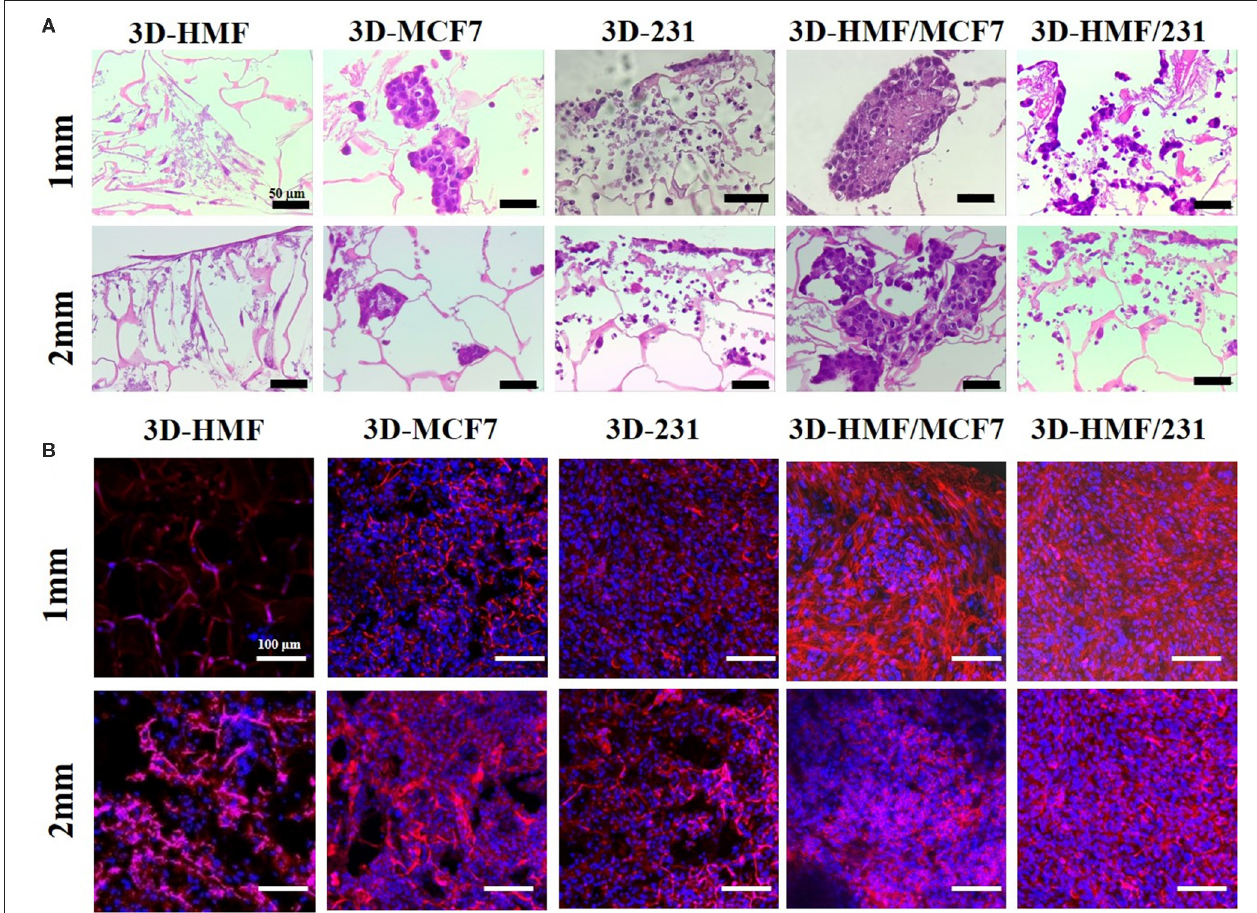
FIGURE 6 | Hematoxylin/eosin staining of developed 3D tumor models constructs at day 14 in both homotypic and heterotypic condition. (A) Shows representative images of the 3D-BCM: tumor cells are arranged in spheroid-like architecture (3D-MCF7 and 3D-HMF/MCF7). MDAMB-231 cells spread along the scaffold and do not show an acinar structure (Scale bar 50 µ m). (B) Representative image of nuclei and cytoskeleton, respectively, stained by DAPI (blue) and Phalloidin (red) (Scale bar 100 µ m). The images showed a higher density of cells in heterotypic 3D-HMF/MCF7 and 3D-HMF/231. All the images refer to day 14 of cell